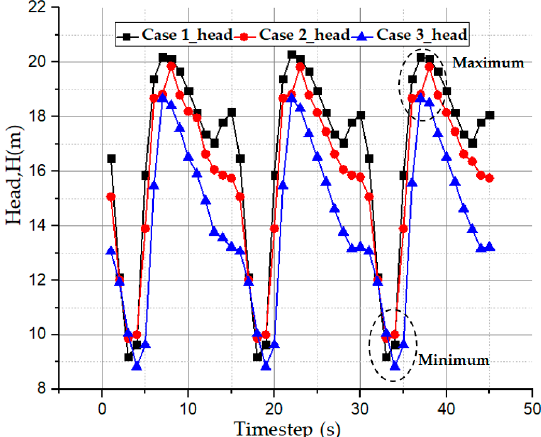
Figure 3. Head fluctuation curve.